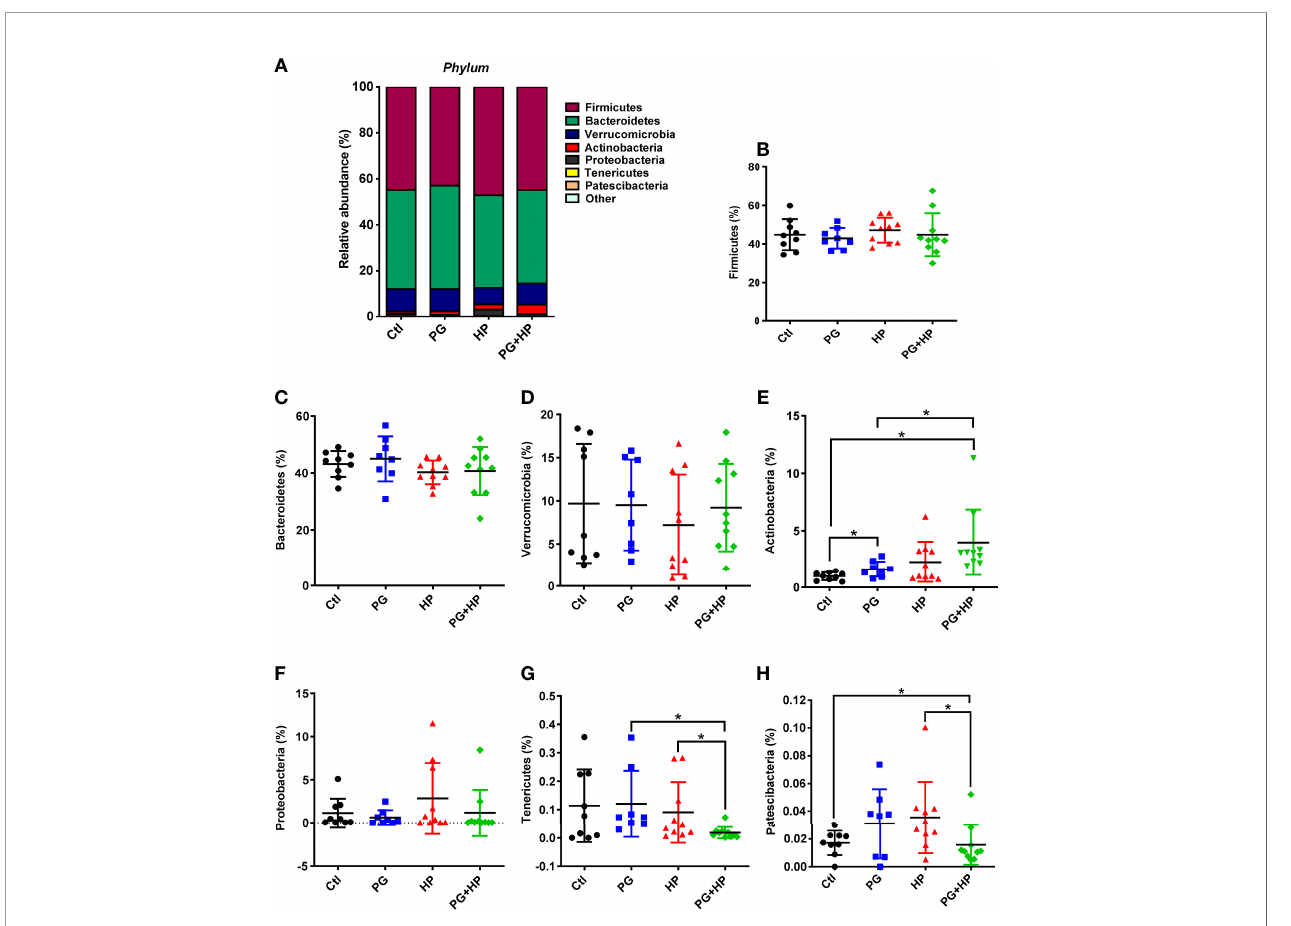
FIGURE 3 | Relative abundance of the gut microbiota in phyla. The bacteria taxonomic pro fi les at phylum in the gut microbiota in P. goldsteinii MTS01-treated and H. pylori -infected mice. (A) Top seven most abundant phyla in the four murine groups were analyzed. Relative abundance of (B) Firmicutes, (C) Bacteroidetes, (D) Verrucomicrobia, (E) Actinobacteria, (F) Proteobacteria, (G) Tenericutes, and (H) Patescibacteria in the gut microbiota community were assessed. * P <